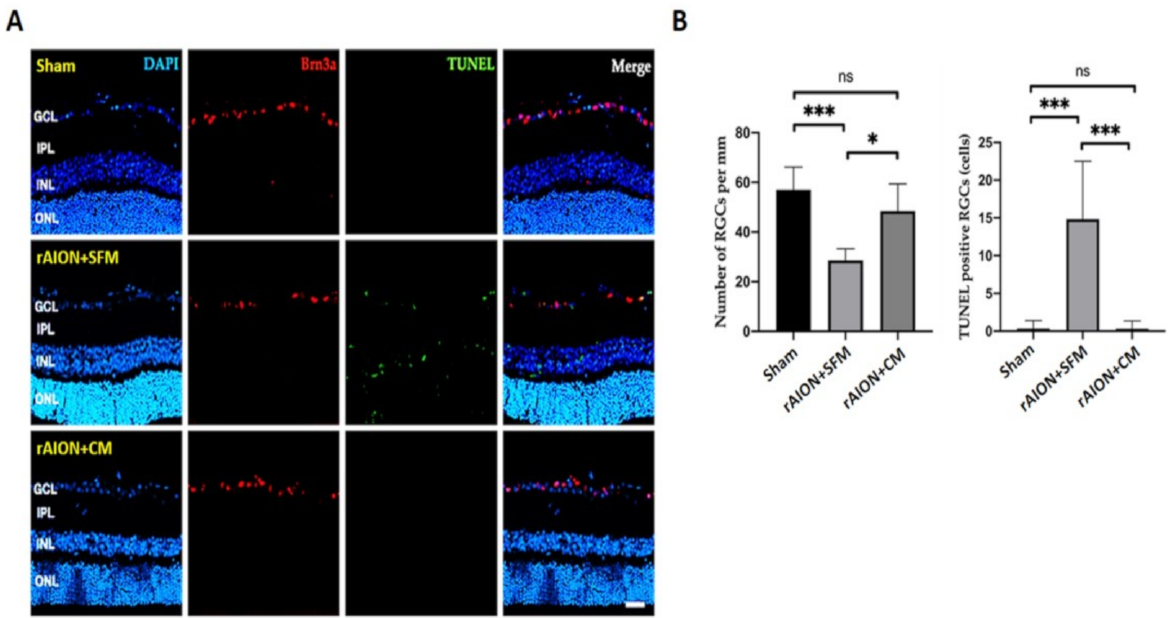
Figure 7. The RGC density and the number of apoptotic RGCs in the 4th week after rAION induction ( A ) Representative images of RGCs (Brn3a-positive cell) in red and TUNEL-positive cells in green. ( B ) Quantification of the RGC density and the number of TUNEL-positive cells. Treatment with CM significantly preserved the RGC density after ON infarct. The apoptotic RGCs were significantly reduced after CM treatment. * p < 0.05; *** p < 0.001. Scale bar: 40 µ m. DAPI, 4, 6-diamidino-2-phenylindole; Brn3a, brain-specific homeobox/POU domain protein 3A; TINEL: Terminal deoxynucleotidyl transferase dUTP nick end labeling; GCL: ganglion cell layer, IPL: inner plexiform layer, INL: inner nuclear layer; ONL: outer nuclear